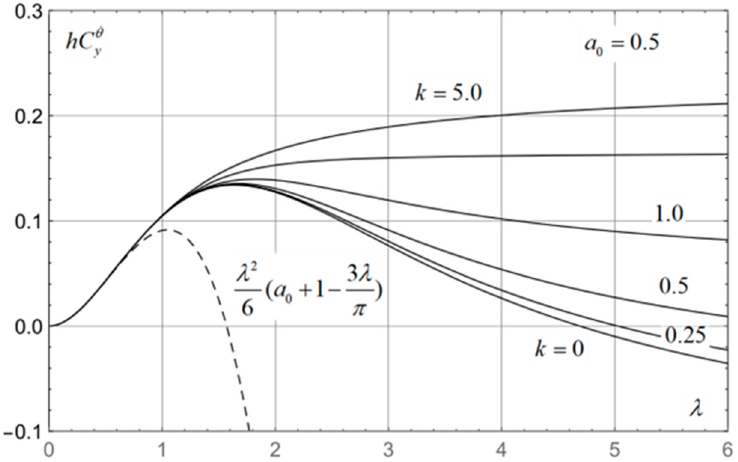
Figure 13. Derivative y hC θ for a rectangular wing in extreme ground effect versus aspect ratio for a 0 = 0.5 and different Strouhal numbers.